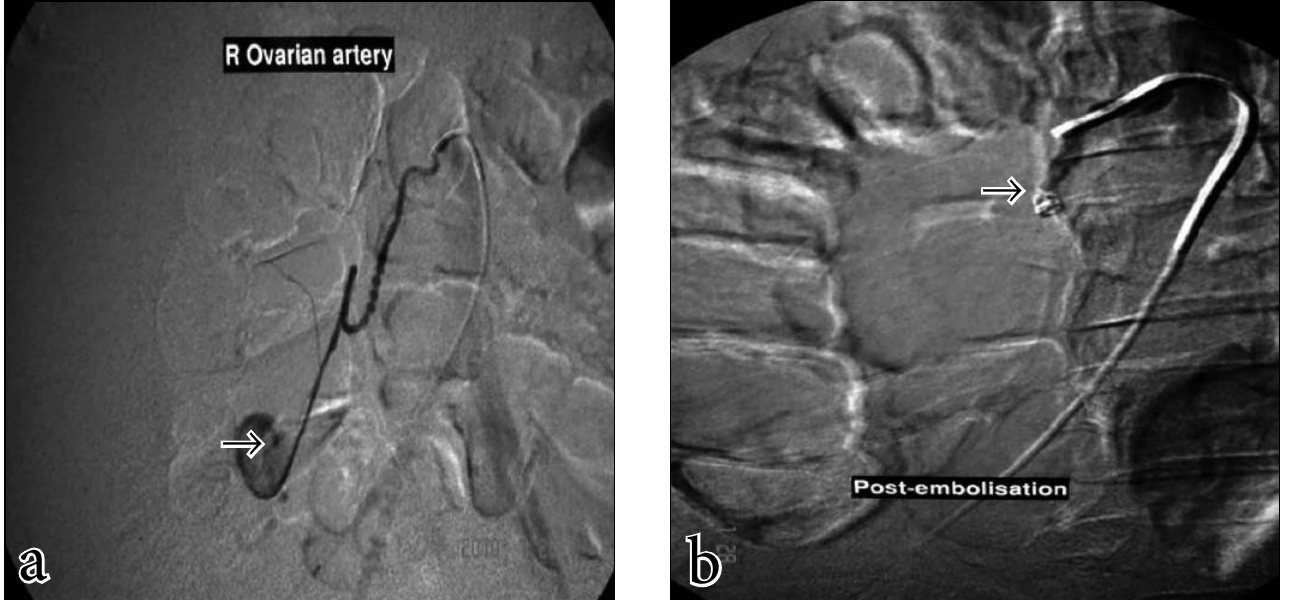
Fig. 2a. Angiogram demonstrating ovarian artery aneurysm/contrast extravasation (arrow). Fig. 2b. Following successful coil embolisation of the right ovarian